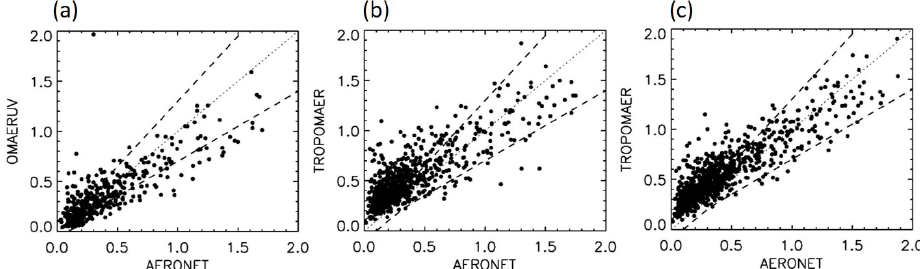
Figure 3. AERONET–satellite comparisons of OMI-retrieved 388nm AOD (a) , TROPOMI using heritage cloud screening (b) , and TROPOMI using VIIRS cloud mask (c) . The dotted line indicates the one-to-one line, and dashed lines represent expected retrieval un- certainty (largest of 0.1% or 30%). See text and Table 2 for details.